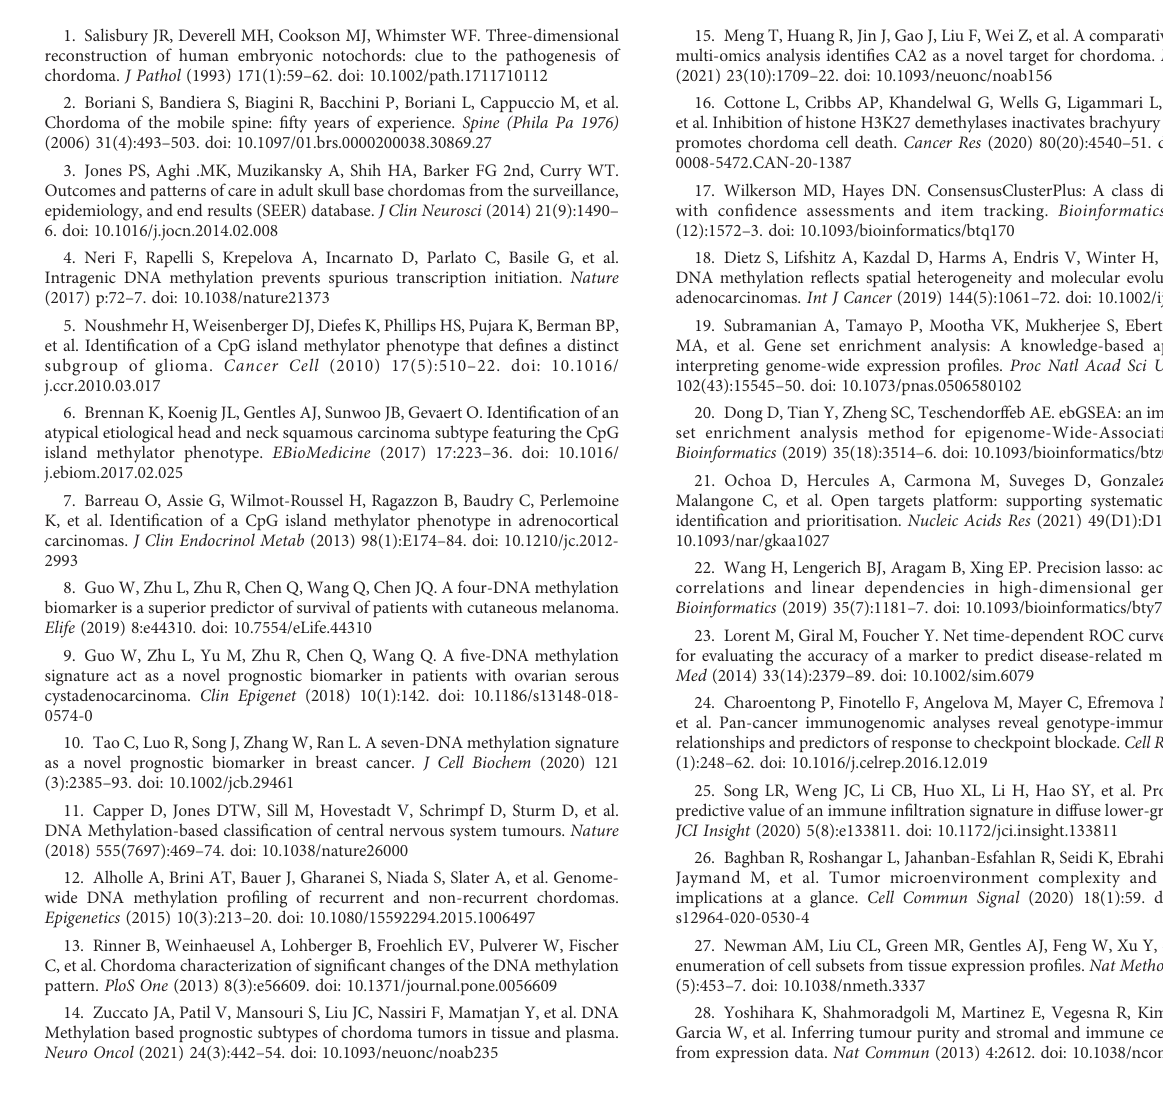
SUPPLEMENTARY TABLE 1 Clinical information of 46 patients. SUPPLEMENTARY TABLE 2 Relationship between potential drugs with chordomas (the Open Targets